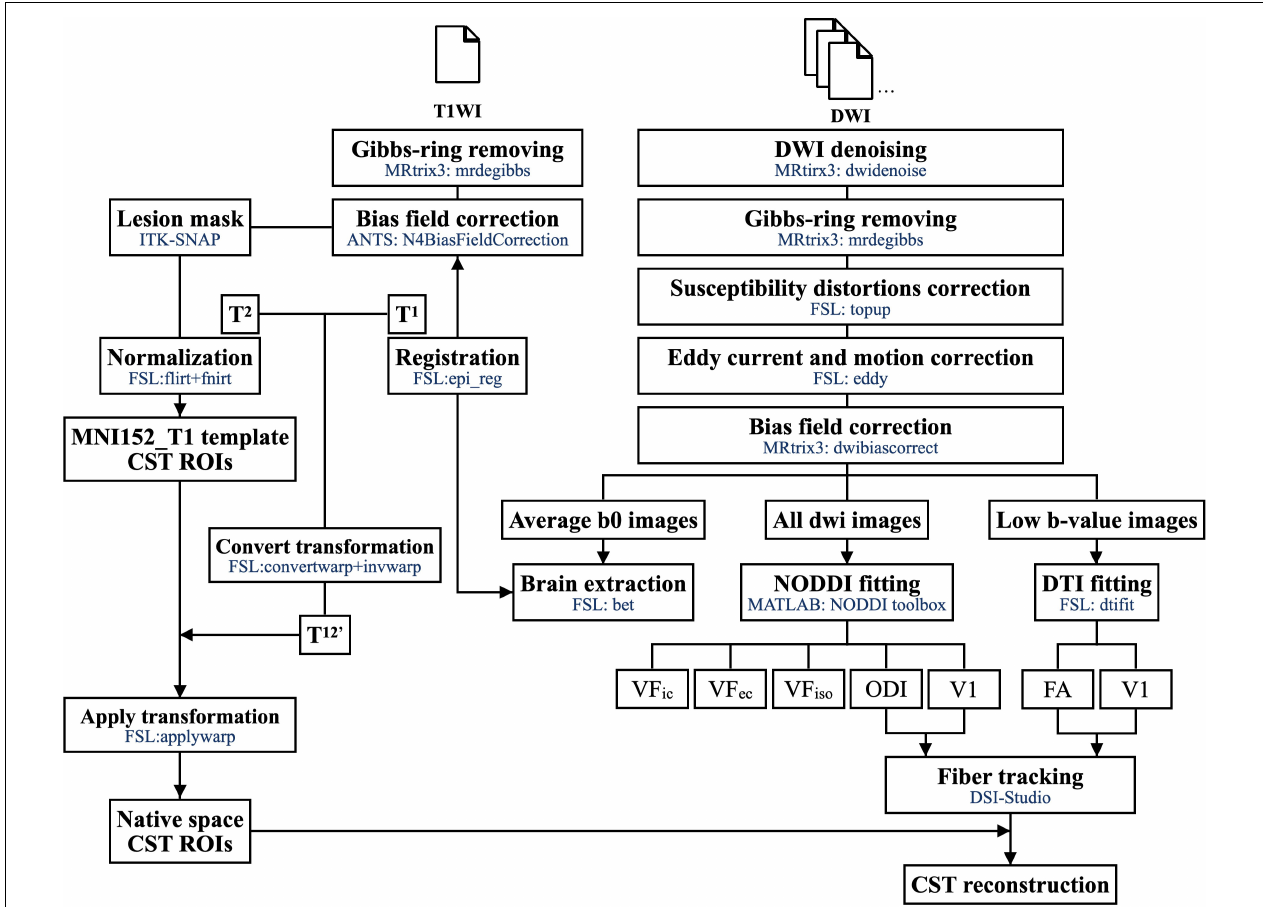
FIGURE 1 | The imaging processing